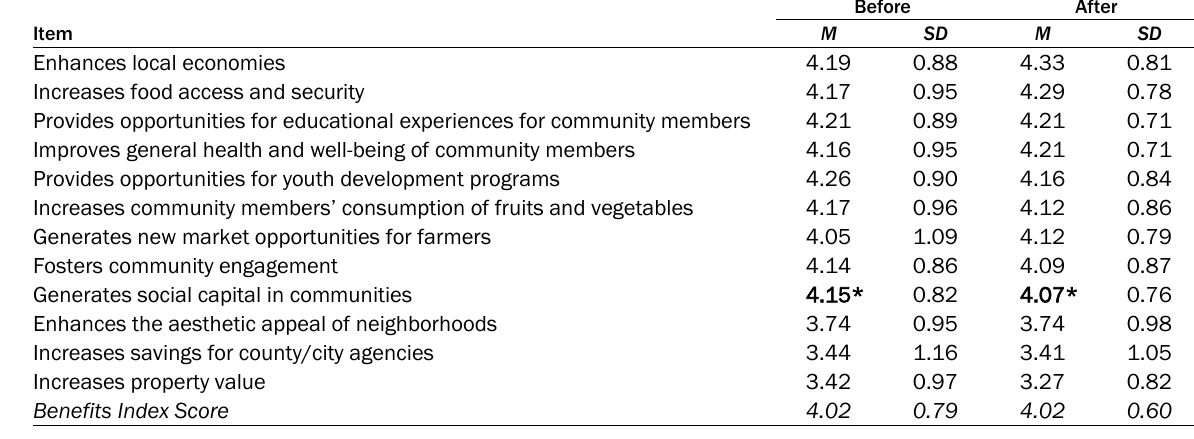
Table 14. Perceived Benefits of Local Food Production Before and After COVID-19 ( n =43)